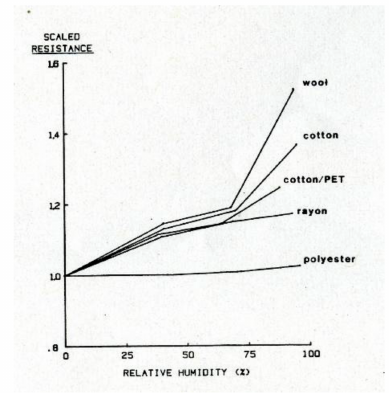
Figure 8. E ff ect of moisture absorption on air flow resistance through a variety of conventional fabrics